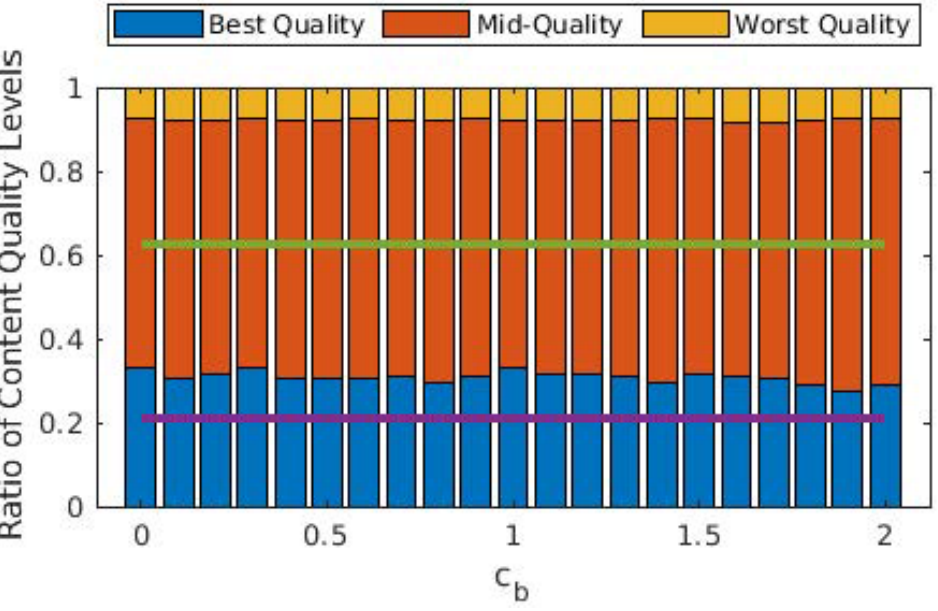
Figure 8. Ratios of the GOPs with respect to quality for different values of c b . Purple and green lines show the best and (cumulative) mid-quality ratios when D2D mode is